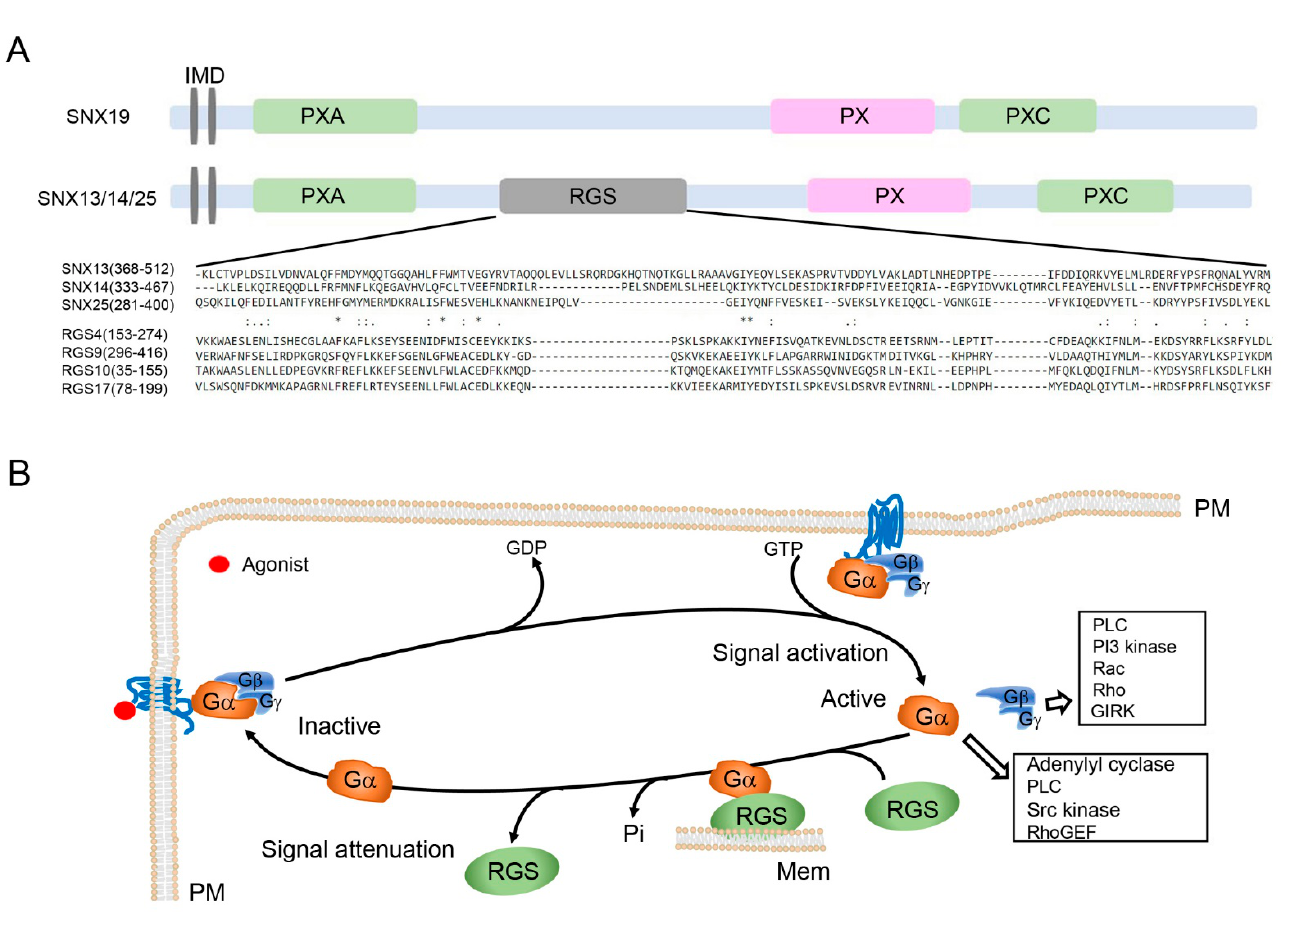
Figure 1. Unique RGS domain in the structure of SNX-PXA-RGS-PXC subfamily. ( A ) Domain organization of SNX-PXA- RGS-PXC subfamily. All members of this subfamily, except SNX19, have unique RGS domains, which are aligned with RGS proteins, as shown. Asterisk denotes identical amino acid residues among all of the seven peptides, one dot indicates the weakly conserved amino acid residues, and double dots indicate the well-conserved amino acid residues among all of the peptides. IMD, integrated transmembrane domain. ( B ) RGS proteins in the G protein nucleotide cycle. Upon agonist binding, receptors activate heterotrimeric G proteins, which induce the exchange of GDP for GTP and dissociation of G α from G βγ , attenuation of G α subunit’s activation (G α s ) or inhibition (G α i ) of its downstream effectors. The effect is terminated by GTPase or the intrinsic GTPase activity of G α , where RGS is separated from G α s. RGS proteins or SNX13 facilitates the hydrolysis of GTP by G α s, as a GTPase-activating protein. G α , G alpha subunit; G β , G beta subunit; GDP, guanosine diphosphate; G γ , G gamma subunit; GIRK, G protein-coupled inwardly rectifying potassium; GTP, guanosine triphosphate; Mem, intracellular membranes; PI3 kinase, phosphoinositide 3-kinase; PLC, phospholipase C; PM, plasma membrane; Rac, Rac G protein; RGS, regulators of G protein signaling; Rho, Rho G protein; RhoGEF, guanine nucleotide exchange factor for Rho; Scr kinase, Src family